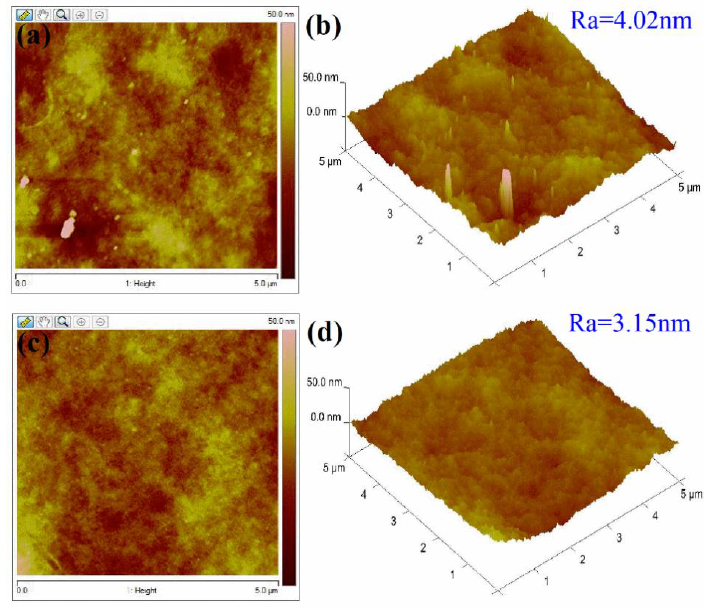
Figure 4. Representative 2D and 3D AFM images of the surfaces of ( a , b ) the PPSU support and ( c , d ) the PANI-coated PPSU membrane.